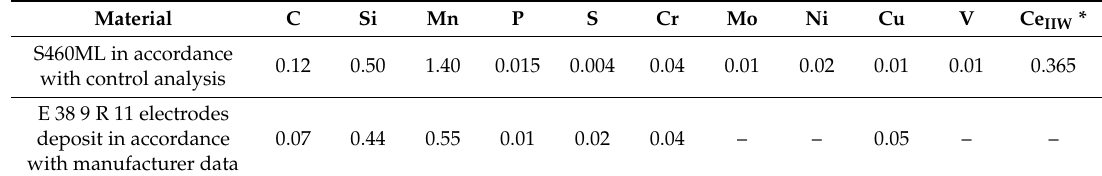
Table 1. Chemical composition of used materials wt.%.